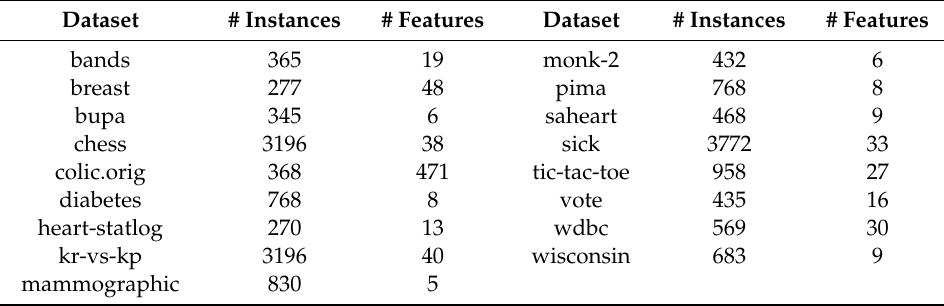
Table 1. Description of datasets used from the UCI